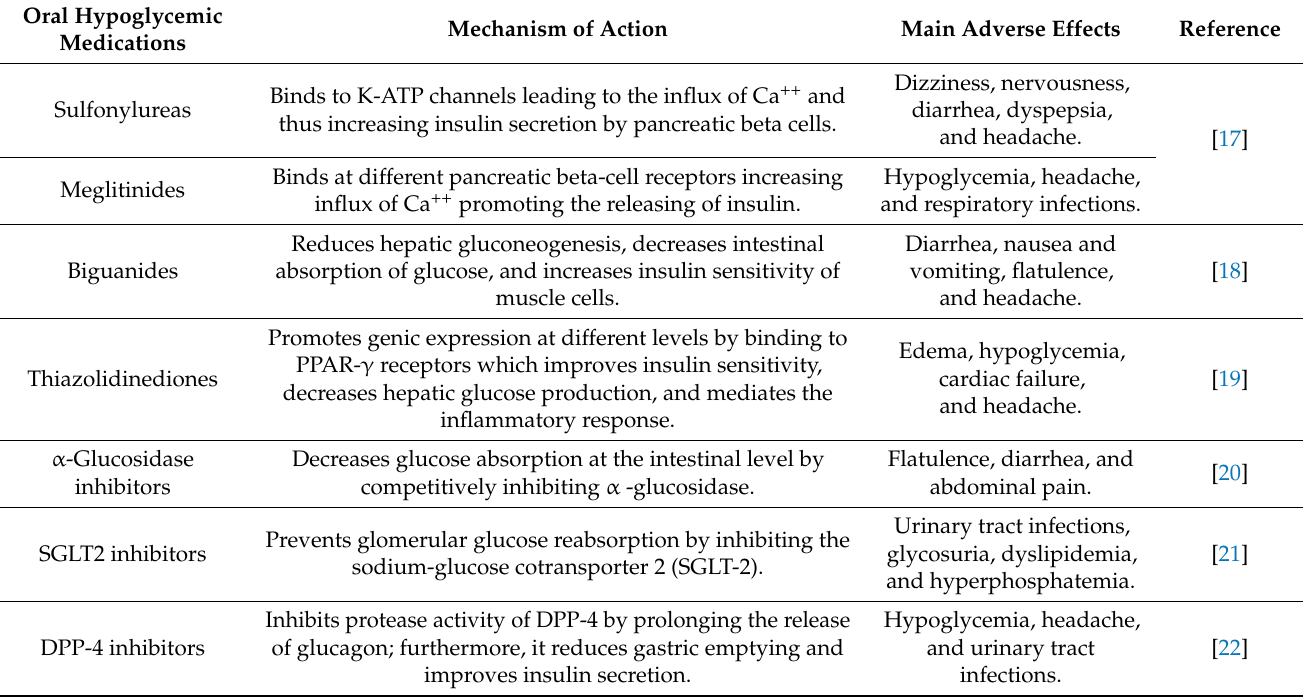
Table 1. Classification of the main oral hypoglycemic medications used in the treatment of